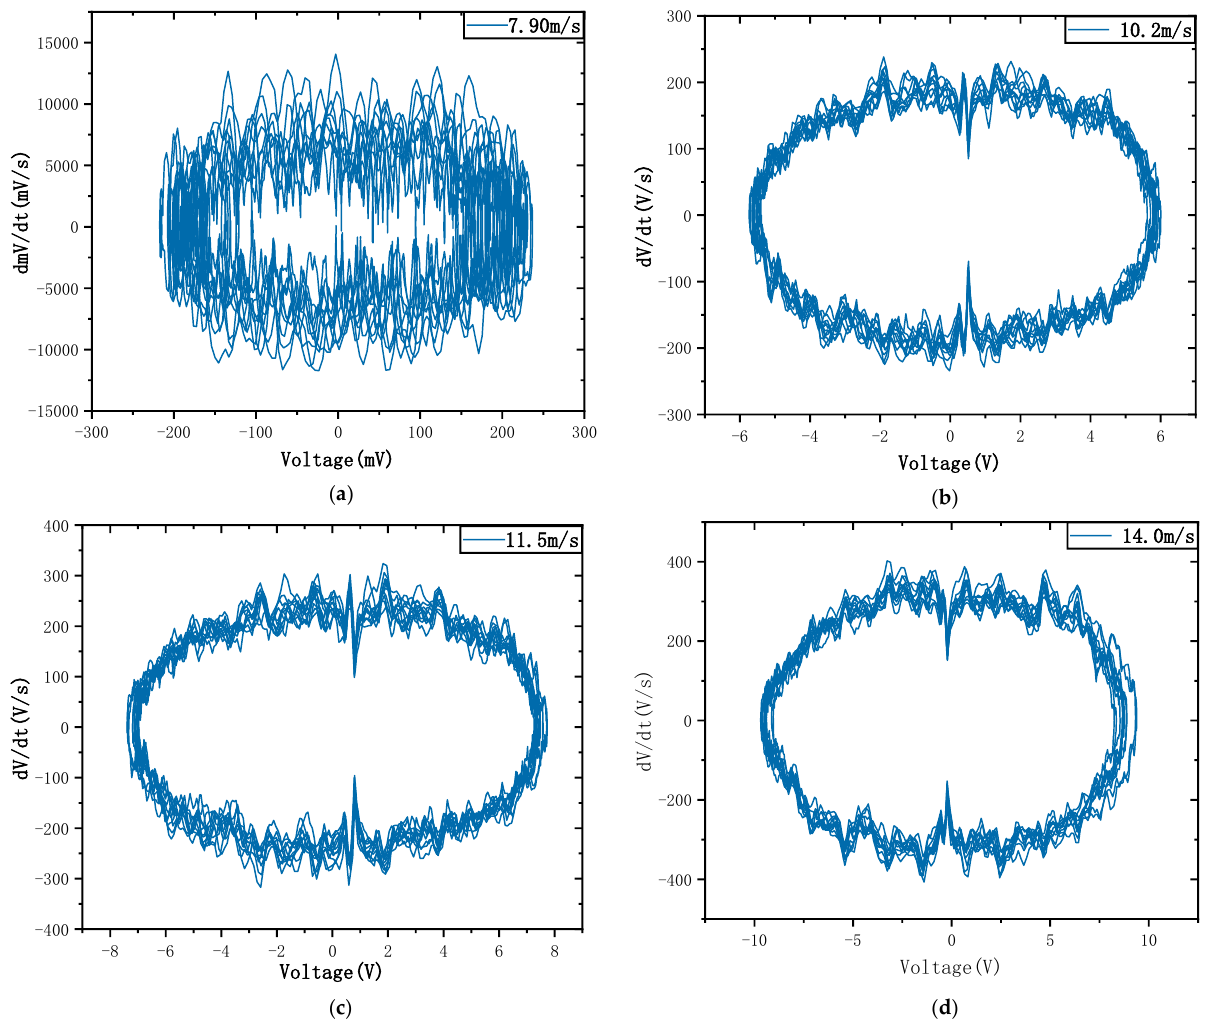
Figure 9. Phase diagram of FEH at different wind velocities: ( a ) Wind velocity of 7.9 m/s; ( b ) Wind velocity of 10.2 m/s; ( c ) Wind velocity of 11.5 m/s; ( d ) Wind velocity of 14.0 m/s. It can be seen from Figure 9 that FEH produced limit cycle oscillation during the experiment. When the wind velocity is 7.90 m/s, the starting wind velocity is not reached, and the aerodynamic force on the symmetrically distributed airfoil components is uneven, resulting in more chaotic phase diagrams at the current velocity. The phase portraits of output voltage appear approximately as a single cycle, while the phase portrait does not appear to be very smooth, especially at 7.9 m/s. The reason is that there exist the unexpected disturbances in the experiment. When the wind velocity is 8.5 m/s,